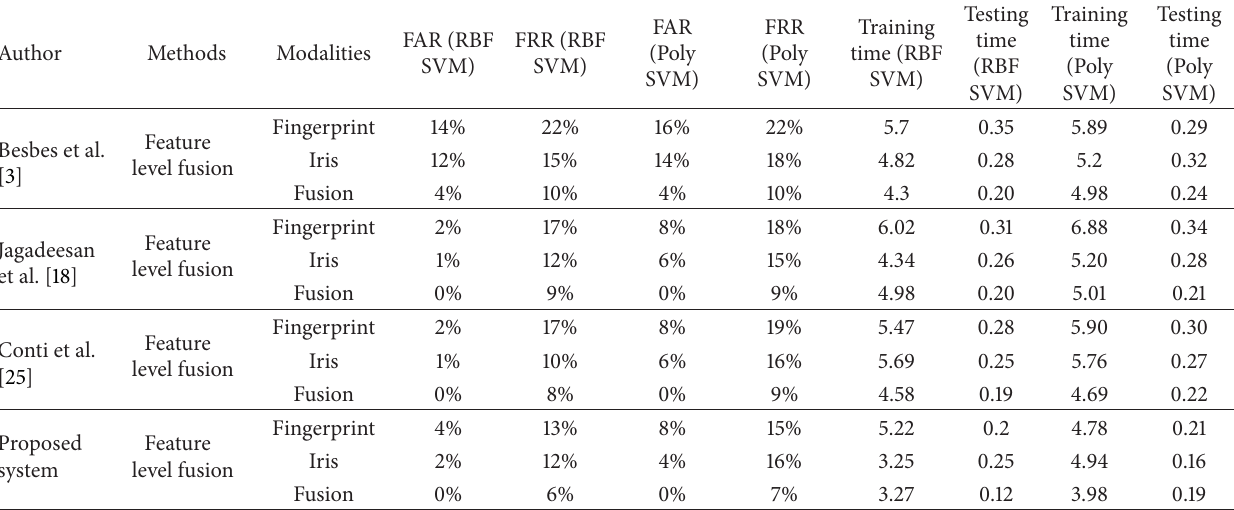
Table 2: Comparison of the proposed approach with Besbes et al. [3], Jagadeesan et al. [18], and Conti et al. [25] (FAR, FRR, and response time (mean) in seconds).